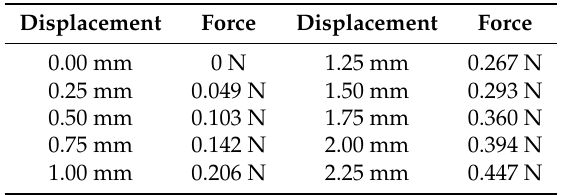
Table 1. Measurement of force and displacement of suspended